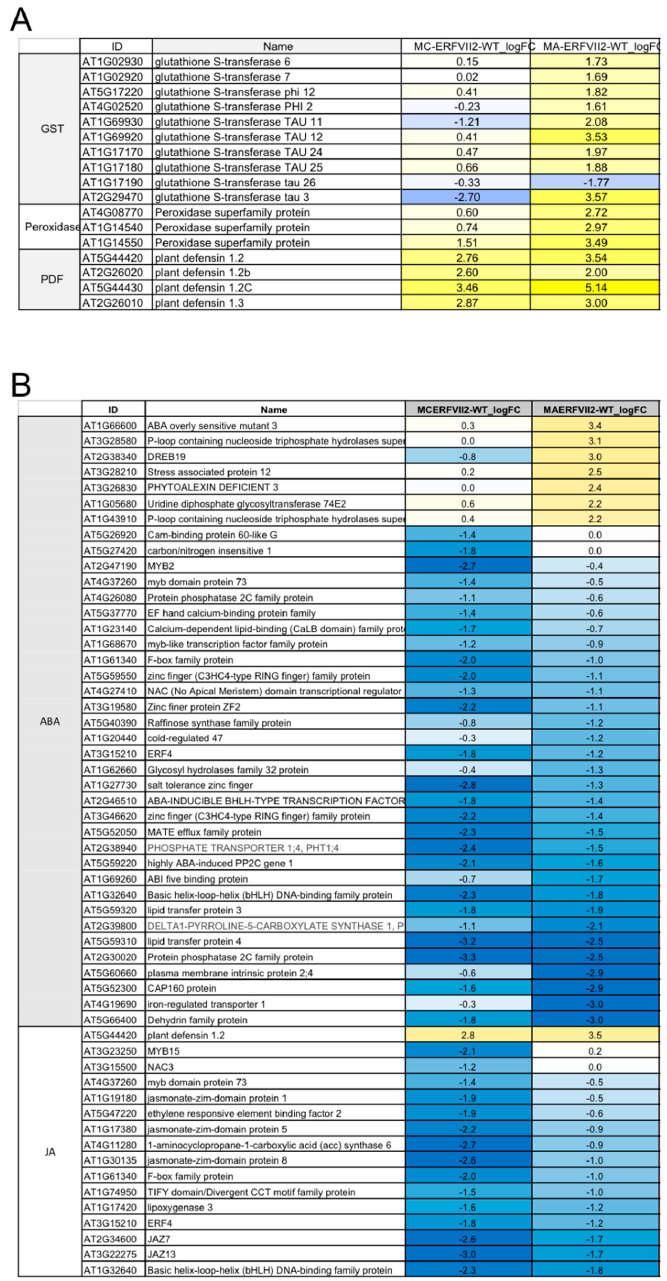
Figure 6. Gene expression pattern of DEGs related to ( A ) ROS scavenging and pathogen responses and ( B ) ABA and JA responses. Blue and yellow colors indicate upregulation and down regulation, respectively. Data used to generate this figure can be found in Supplementary Materials Table S1.